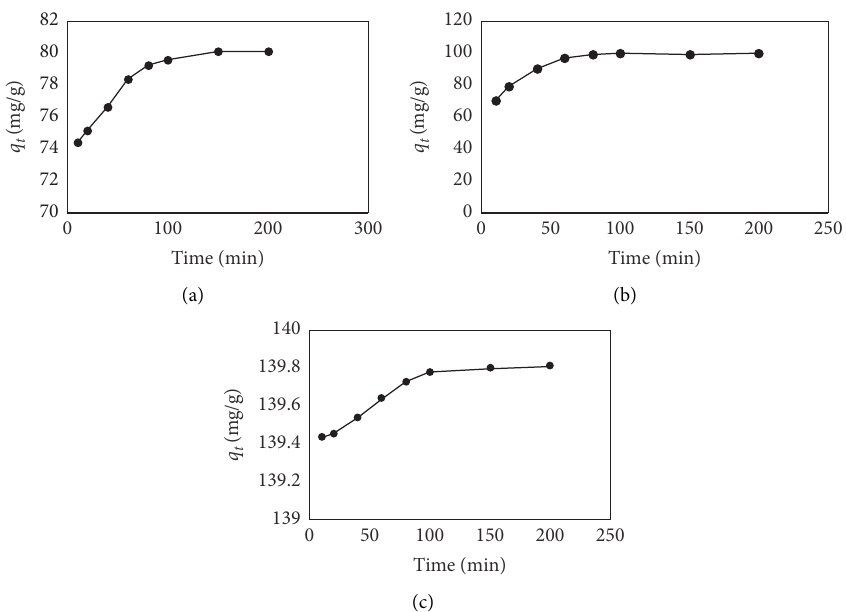
Figure 8: Effect of contact time for MB removal by MSNs-Cys from aqueous solution at (a) pH 1.5, (b) pH 7, and (c) pH 8.5 (150ppm, 25 ° C, and